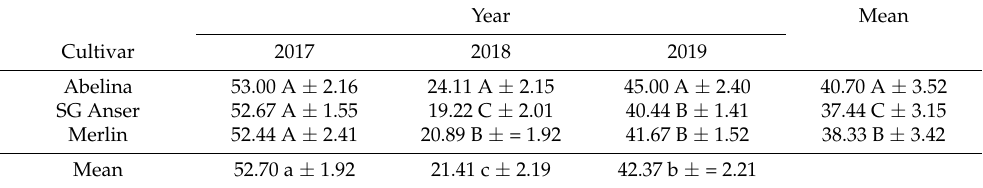
Means in rows followed by different letters in lowercase: a, b and c (for years) differ significantly at p ≤ 0.05. Means in columns followed by different letters in uppercase: A, B, and C (for cultivars and the interaction: